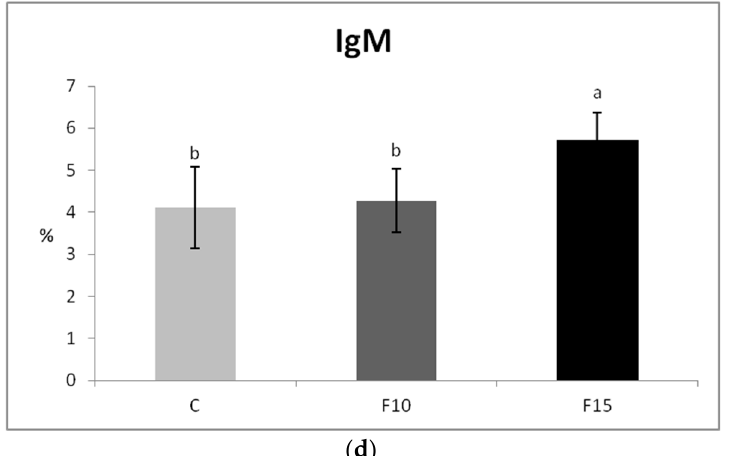
Figure 5. Effect of application of fermented feed on percentage of: ( a ) CD3+, ( b ) CD4+, ( c ) CD8+, ( d ) IgM lymphocytes isolated from peripheral blood in laying hens. Means with different superscripts are significantly different ab p < 0.05.